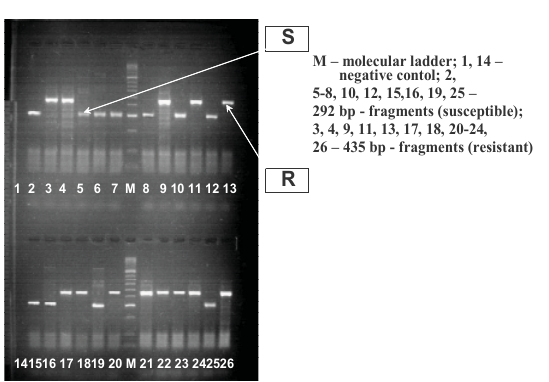
Figure 2. Detection of mutation in codon 315 katG gene for M.tuberculosis